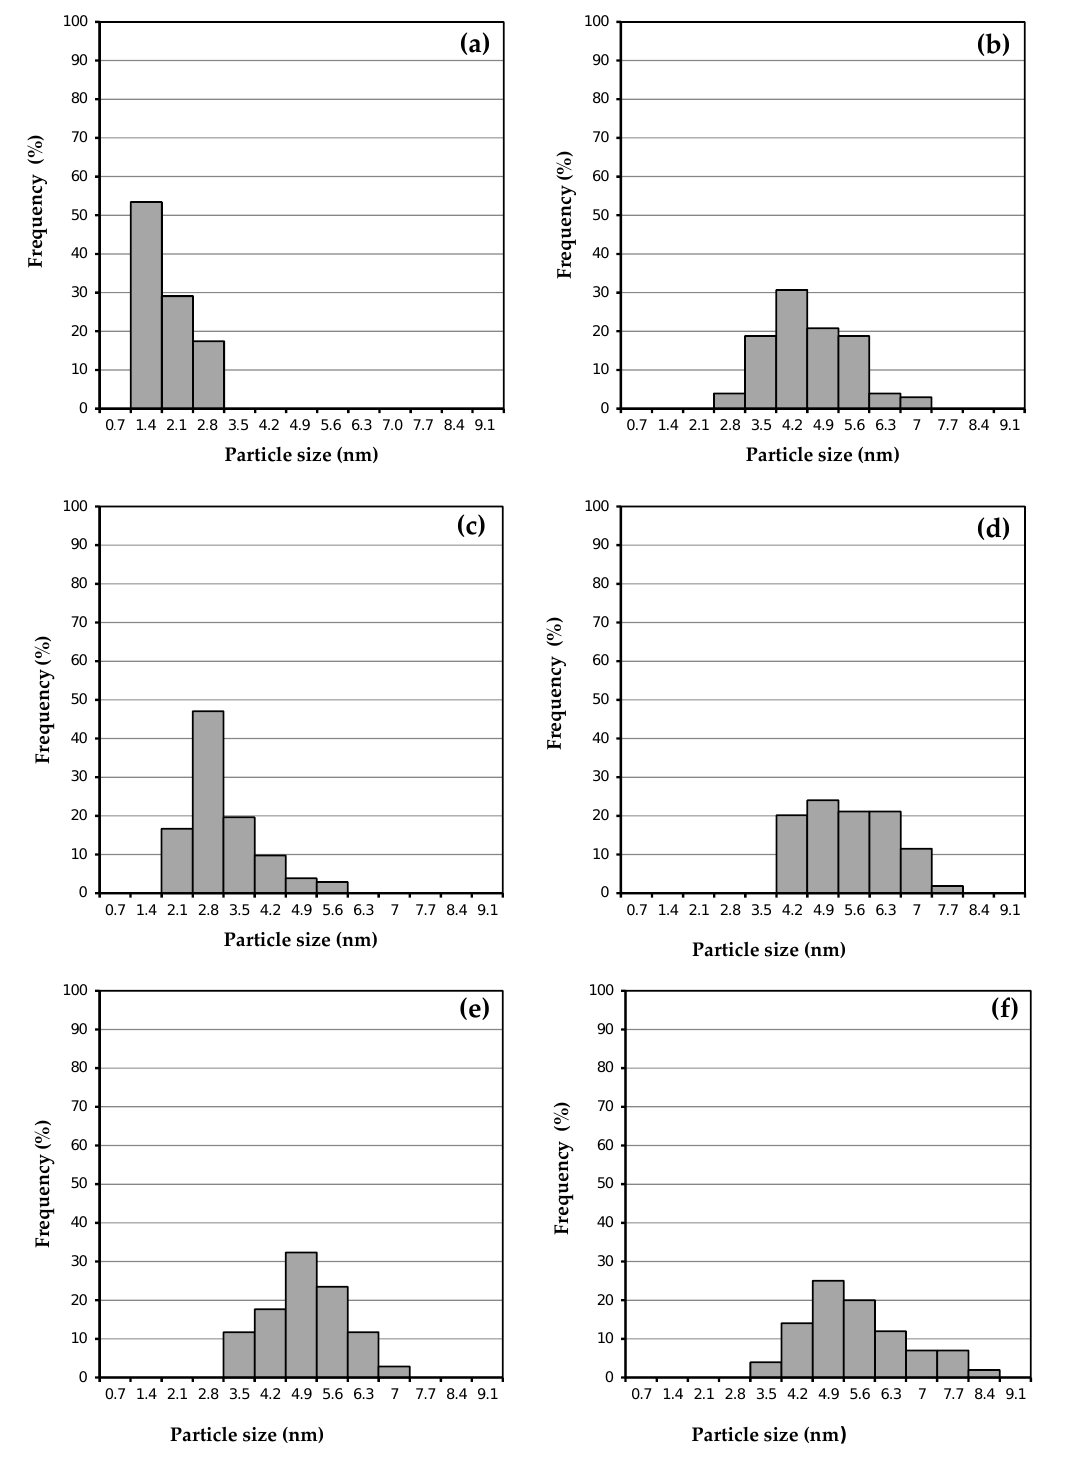
Figure 6. Particle size distributions for the different Ru/Al 2 O 3 -A/AE(10 wt%) catalysts. Without A/AE ( a ), A: Na ( b ), K ( c ), AE: Ba ( d ), Ca ( e ), and Mg ( f ).